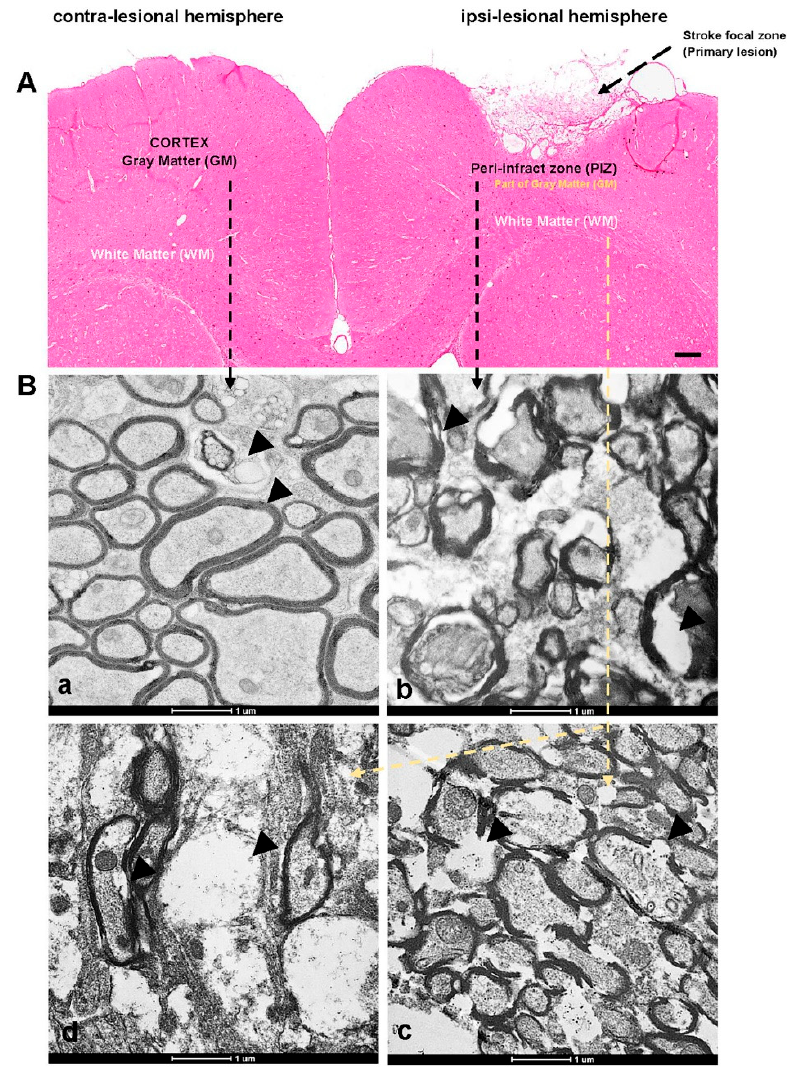
Figure 1. The hematoxylin and eosin (H&E) staining and transmission electron microscopy (TEM) images. ( A ) Contra-lesional and Ipsi-lesional hemispheres of nine weeks stroke brain tissues showing the regions of interest—peri-infract zone (PIZ) and white matter (WM). ( B a ) Representative TEM images of contra-lesional cortex (unaffected neurons), whereas ( B b ) representing ipsi-lesional PIZ (affected side) and ( B c–d ) representing ipsi-lesional WM showing the ultrastructural changes—axonal shearing, formation of vacuoles and swelling marked with black arrows on the images. Scale bar = 100 µm for H&E and 1 µm for TEM.